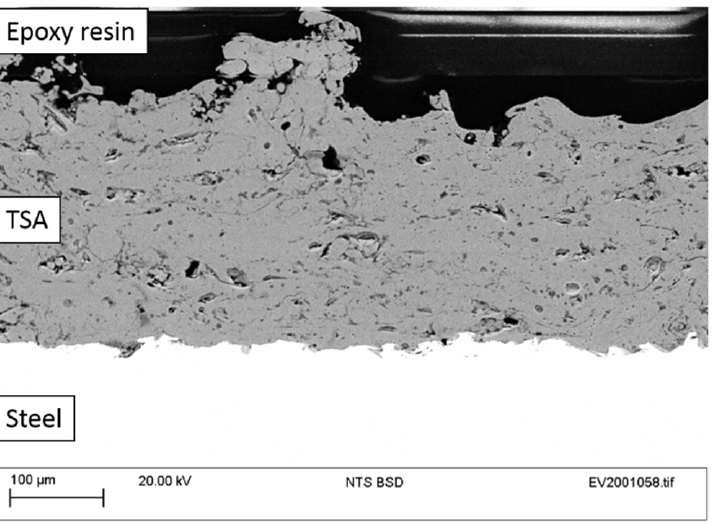
Figure 12. Cross section SEM image of TSA 1050 coating on a steel substrate prior to corrosion testing.